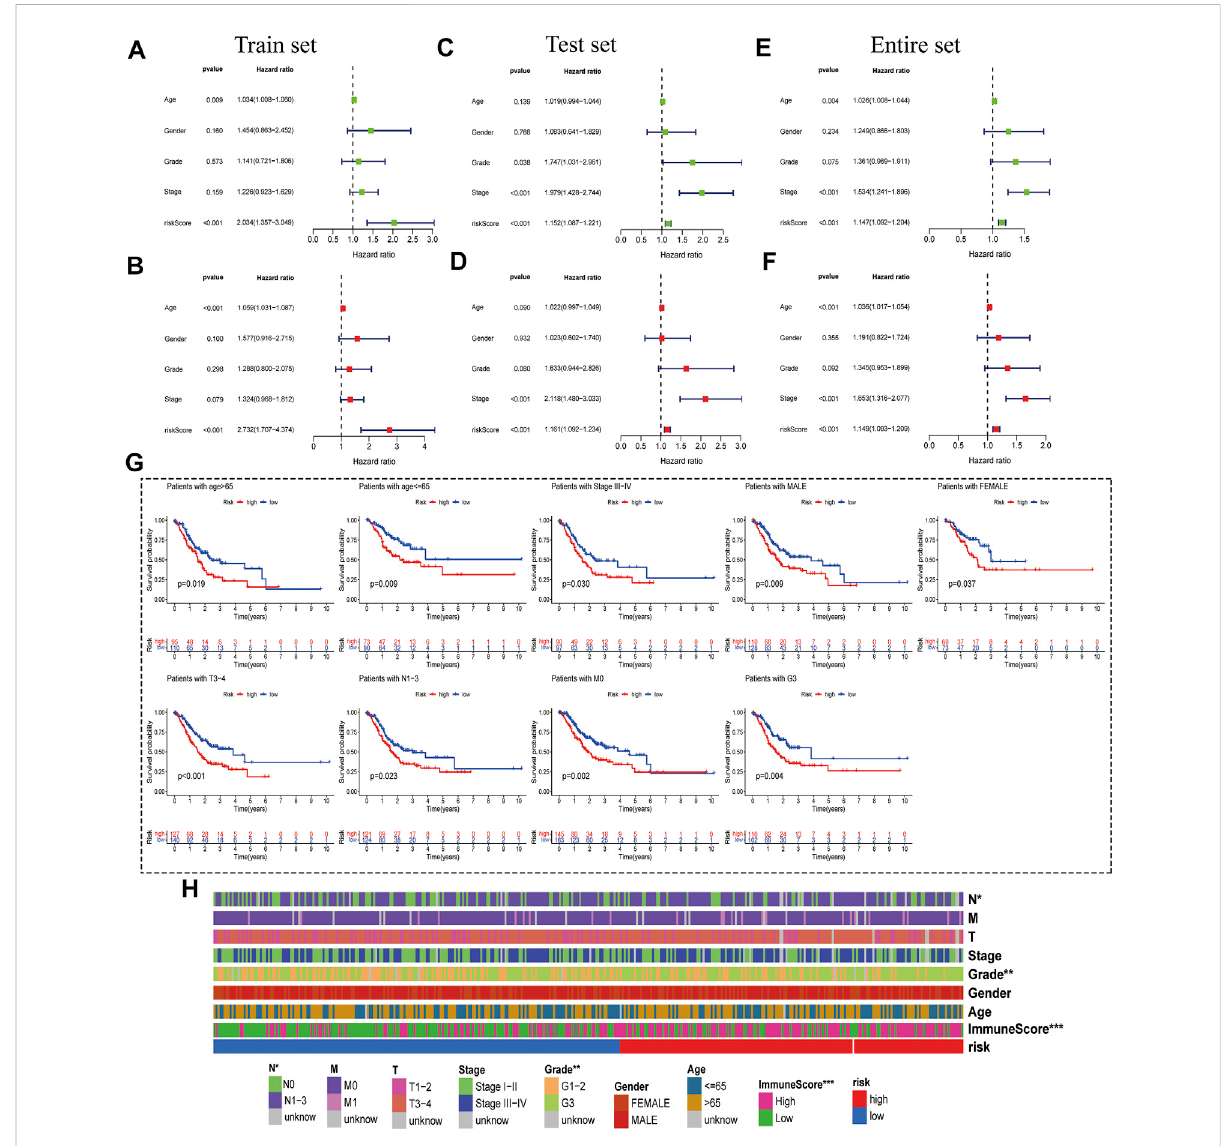
FIGURE 4 Correlation Analysis between risk score and Clinicopathological Features. (A , B) Univariate- and multivariate-Cox analyses of clinical characteristicsandriskscorewithOSofthetraining set. (C , D) Univariate- andmultivariate-Cox analysesofclinicalcharacteristicsandriskscorewith OS of the testing set. (E , F) Univariate- and multivariate-Cox analyses of clinical characteristics and risk score with OS of the entire set. (G) Kaplan- Meier survival curves of the OS of patients between the risk model and clinical characteristics (age, sex, TNM stage, grade, and survival status). (H) Heat-map of correlation between high- and low-risk and patient clinical characteristics (*** p < 0.001 * * p < 0.01 * p <